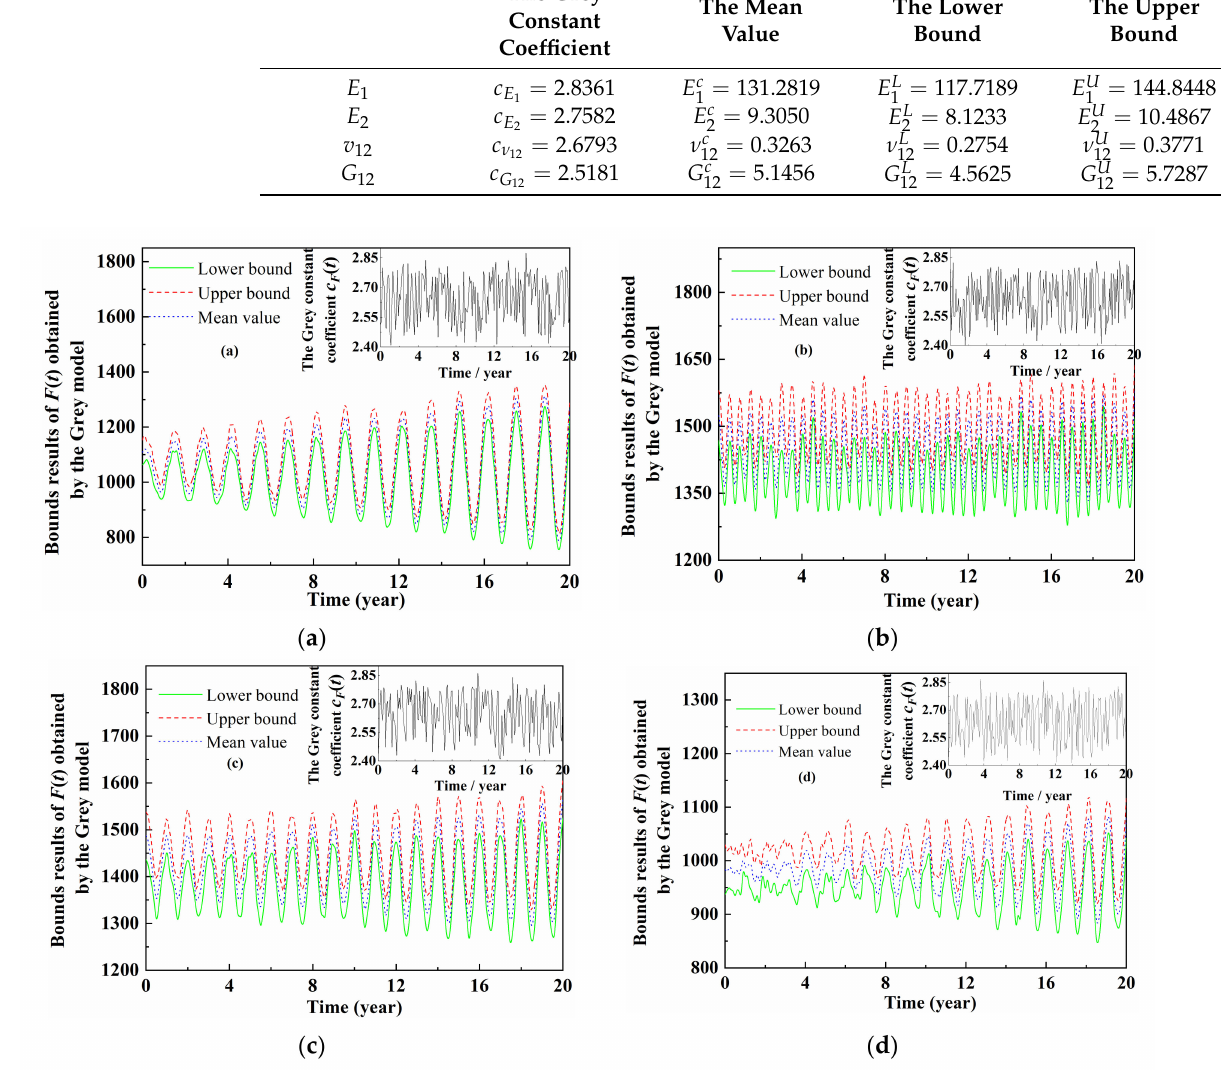
Figure 5. Quantification results for dynamic uncertainty characteristics F ( t ) (Case ( a )–( d